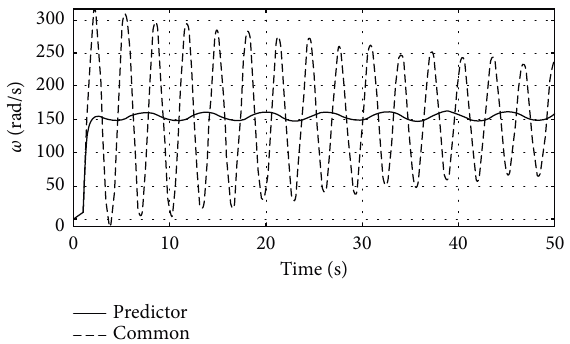
Figure 13: Comparing a predictive-based H controller for τ � 1 s. common H ∞